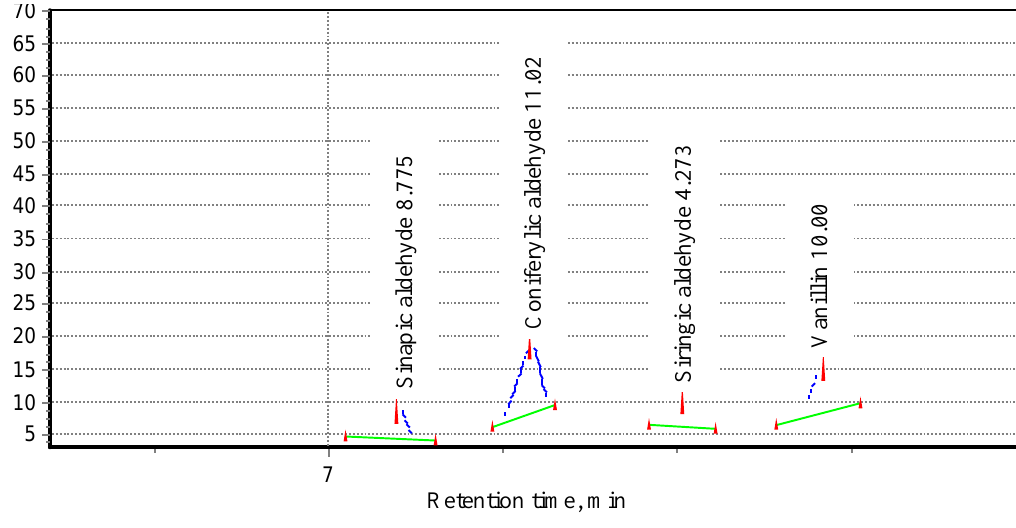
Fig. 1. Electrophoregram of aqueous-alcoholic extract of shell of pine nuts (2-time